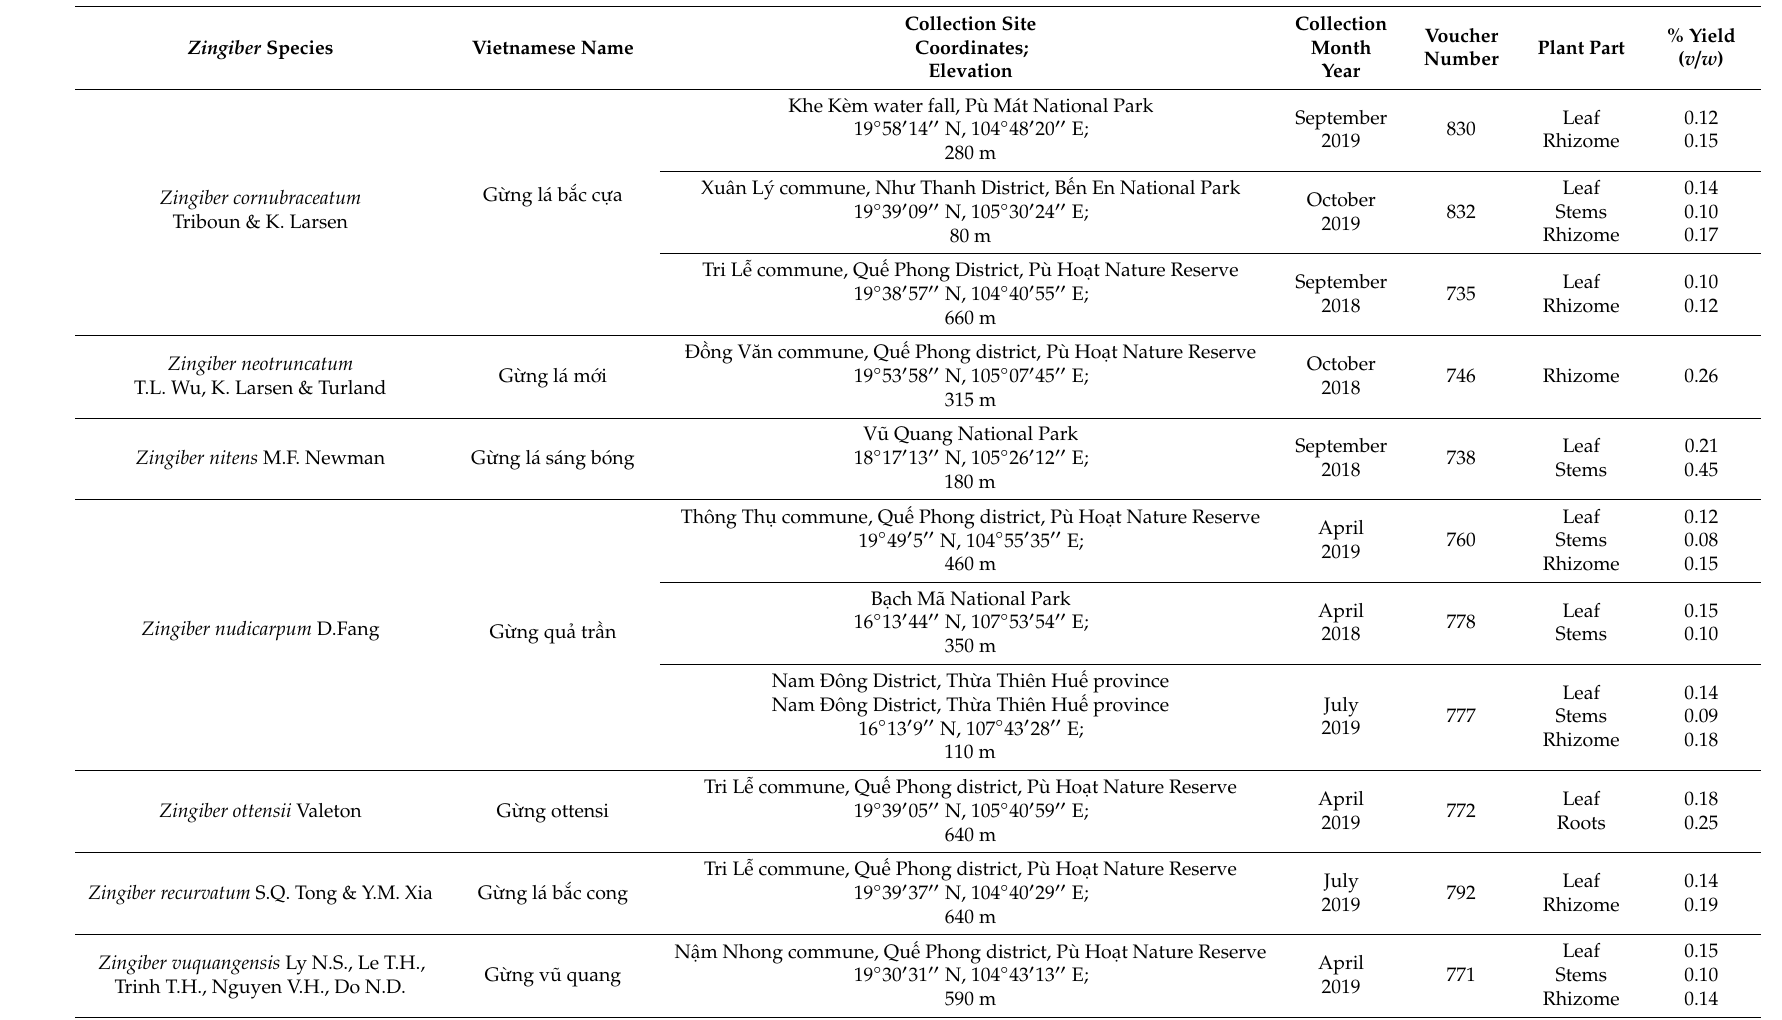
Table 1. Plant collection and hydrodistillation details of Zingiber species from north-central